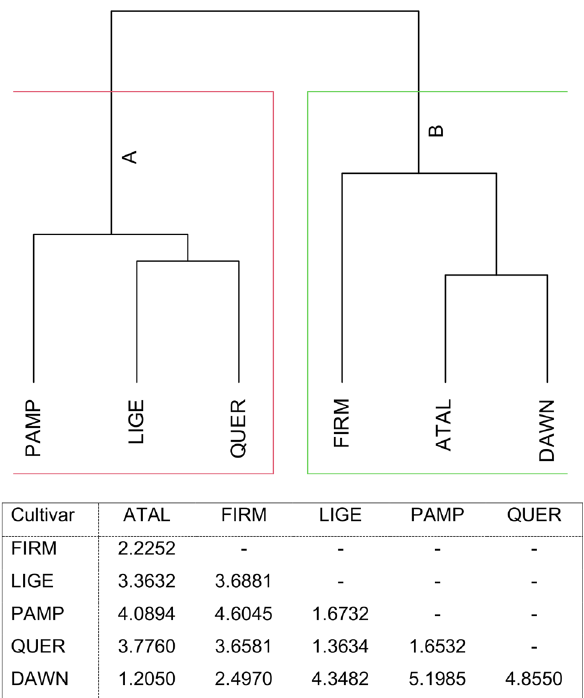
Figure 1. Dendrogram and similarity matrix calculated based on Euclidean distances for rice resistance to the South American rice water weevil, Oryzophagus oryzae, among six rice cultivars in a 2-year field screening. Rice cultivars: ATAL = BRS Atalanta; FIRM = BRS Firmeza; LIGE = BRS Ligeirinho; PAMP = BRS Pampa CL; QUER = BRS Querência; DAWN = Dawn. Variables: numbers of feeding scars and eggs [average from 5, 8, and 11 days after flooding (DAF)], number and weight of larvae [average from 15, 25, and 35 DAF], time to 50% emergence [TE50%], and weight of adult offspring [average between male and